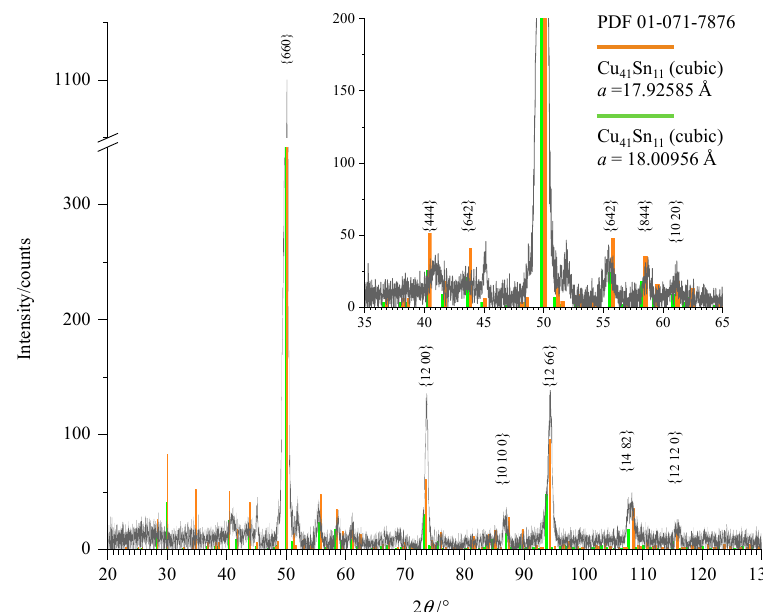
Figure 5. XRD measurement of a Cu–Sn layer with 85% mass fraction of copper obtained from [EMIM]Cl measured with Co K α radiation. According to the PDF-2 database (PDF 01-071-7876), the lattice parameter of the Cu 41 Sn 11 phase is 17.964 Å. For the {660} peak, the corresponding peak orig-